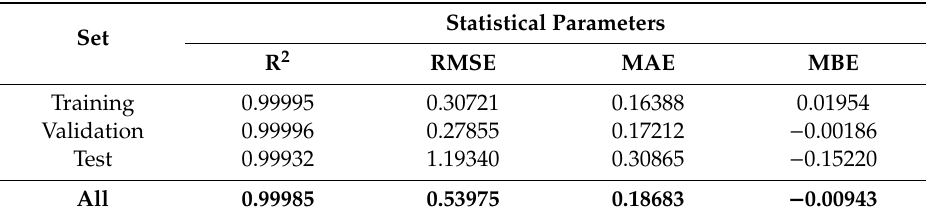
Table 9. Statistical parameters of the ANN11 model.